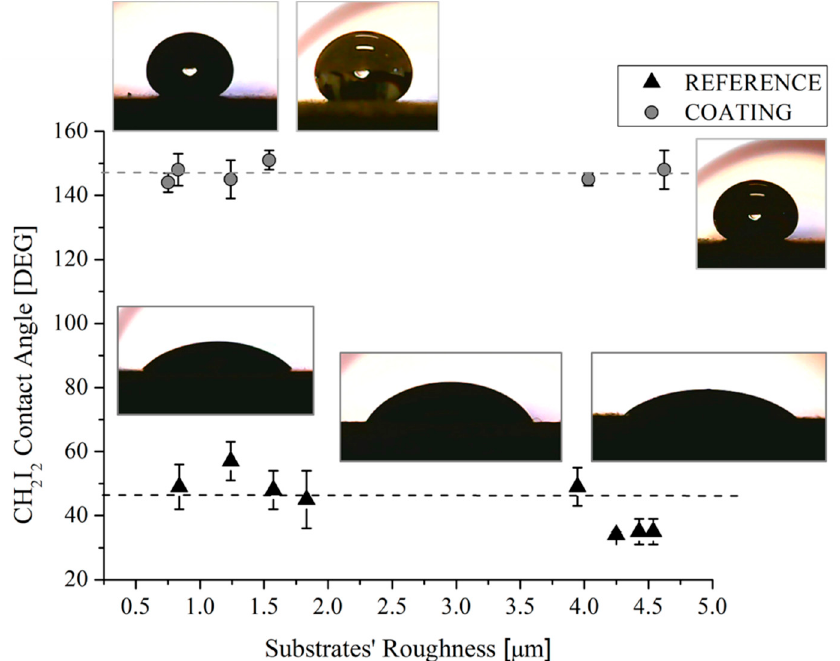
Figure 9. CH 2 I 2 contact angles of reference and coated samples as a function of the substrates’ roughness. Corresponding pictures are also shown.